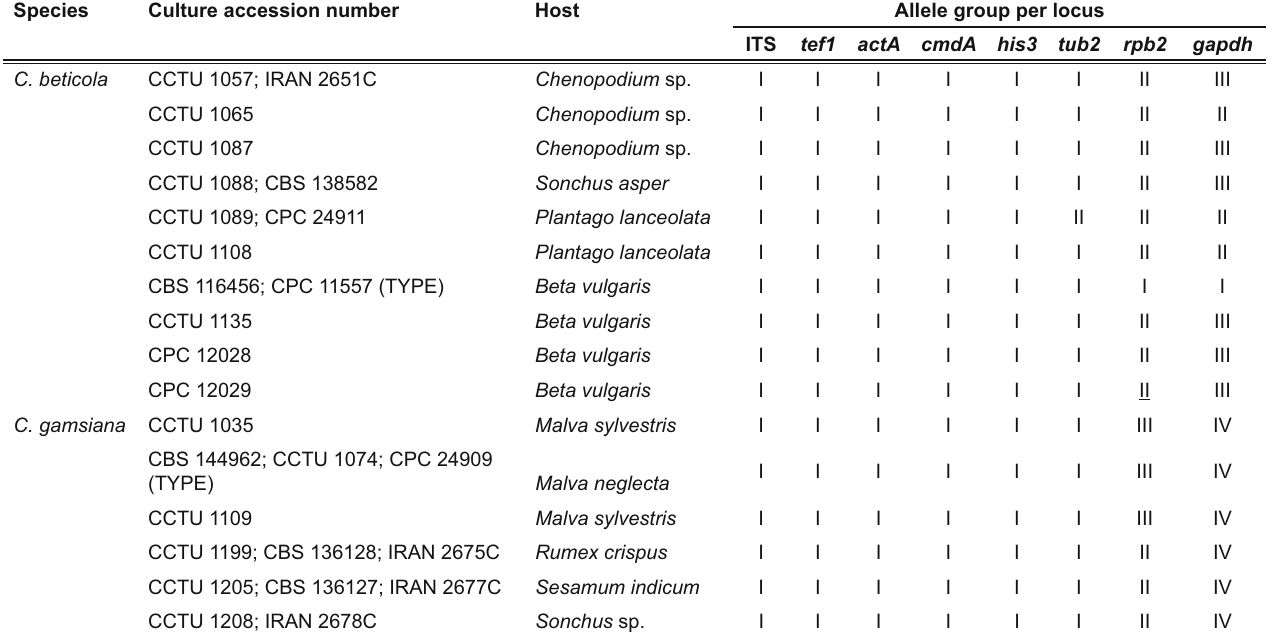
Table 7. G(cid:13)(cid:7)(cid:5)(cid:23)(cid:8)(cid:7)(cid:2)(cid:26)(cid:10)(cid:4)(cid:6)(cid:2)(cid:9)(cid:23)(cid:23)(cid:13)(cid:23)(cid:13)(cid:2)(cid:25)(cid:10)(cid:4)(cid:5)(cid:18)(cid:2)(cid:21)(cid:13)(cid:7)(cid:11)(cid:25)(cid:17)(cid:9)(cid:8)(cid:11)(cid:4)(cid:17)(cid:2)(cid:18)(cid:13)(cid:10)(cid:2)(cid:23)(cid:4)(cid:19)(cid:5)(cid:7)(cid:2)(cid:26)(cid:4)(cid:10)(cid:2) Cercospora beticola s. lat. (cid:2)(cid:11)(cid:7)(cid:4)(cid:23)(cid:9)(cid:8)(cid:13)(cid:7)(cid:2)(cid:11)(cid:17)(cid:2)(cid:8)(cid:14)(cid:11)(cid:7)(cid:2)(cid:7)(cid:8)(cid:5)(cid:21)(cid:22)(cid:28)(cid:2)/(cid:12)(cid:12)(cid:10)(cid:13);(cid:11)(cid:9)(cid:8)(cid:11)(cid:4)(cid:17)(cid:7)(cid:2)(cid:4)(cid:26)(cid:2)(cid:23)(cid:4)(cid:19)(cid:11)(cid:2)(cid:9)(cid:17)(cid:21)(cid:2)(cid:19)(cid:4)(cid:23)(cid:23)(cid:13)(cid:19)(cid:8)(cid:11)(cid:4)(cid:17)(cid:2) (cid:9)(cid:19)(cid:19)(cid:13)(cid:7)(cid:7)(cid:11)(cid:4)(cid:17)(cid:2)(cid:17)(cid:5)(cid:6)(cid:12)(cid:13)(cid:10)(cid:7)(cid:2)(cid:26)(cid:4)(cid:23)(cid:23)(cid:4)(cid:15)(cid:2)<(cid:9)(cid:12)(cid:23)(cid:13)(cid:2)!(cid:28)